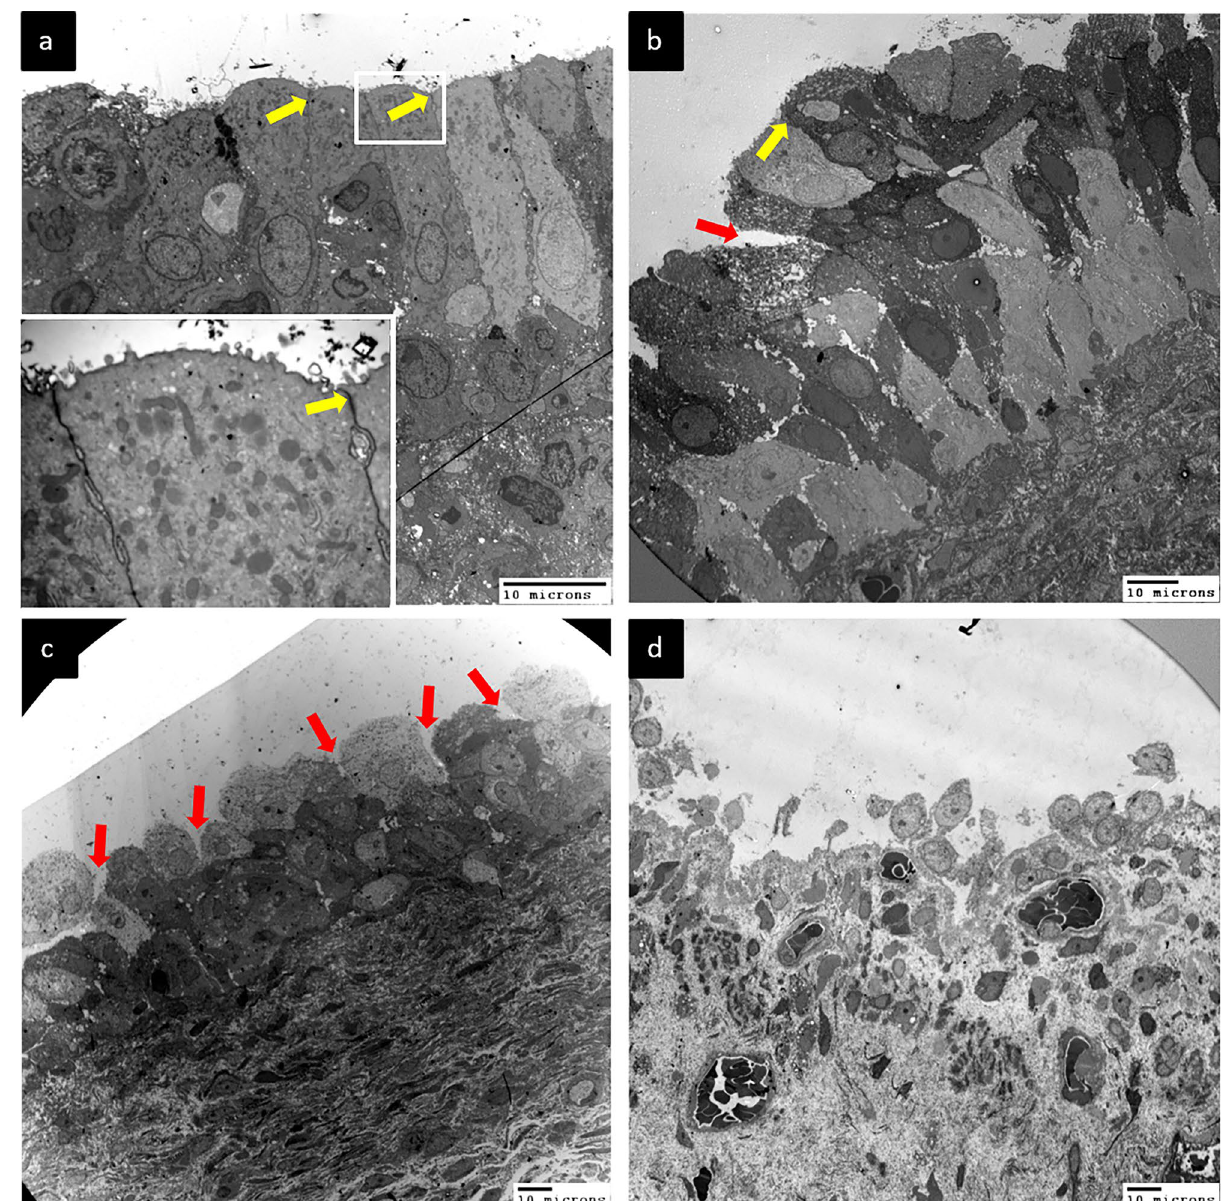
Figure 3. Progressive loss of urothelial tight junctions in patients with higher defect grades. ( a ) A grade 0 sample (control subject) showing a normal urothelium with ubiquitous intact tight junctions (yellow arrows). Insert shows the intact tight junction at higher magnification. ( b ) A grade 1 sample with tight junction defects (red arrows) between at least 25% of umbrella cells. ( c ) A grade 2 sample with tight junction defects between 25 and 50% of umbrella cells. ( d ) A grade 3 sample with tight junction defects between > 50% of umbrella